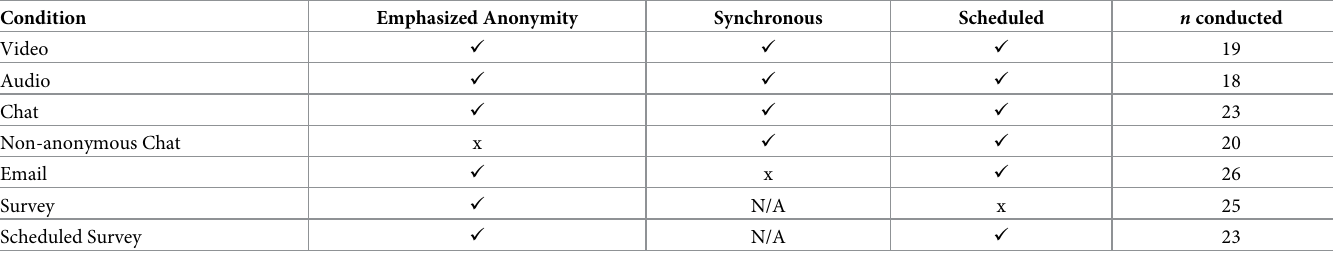
Table 1. Summary of experimental